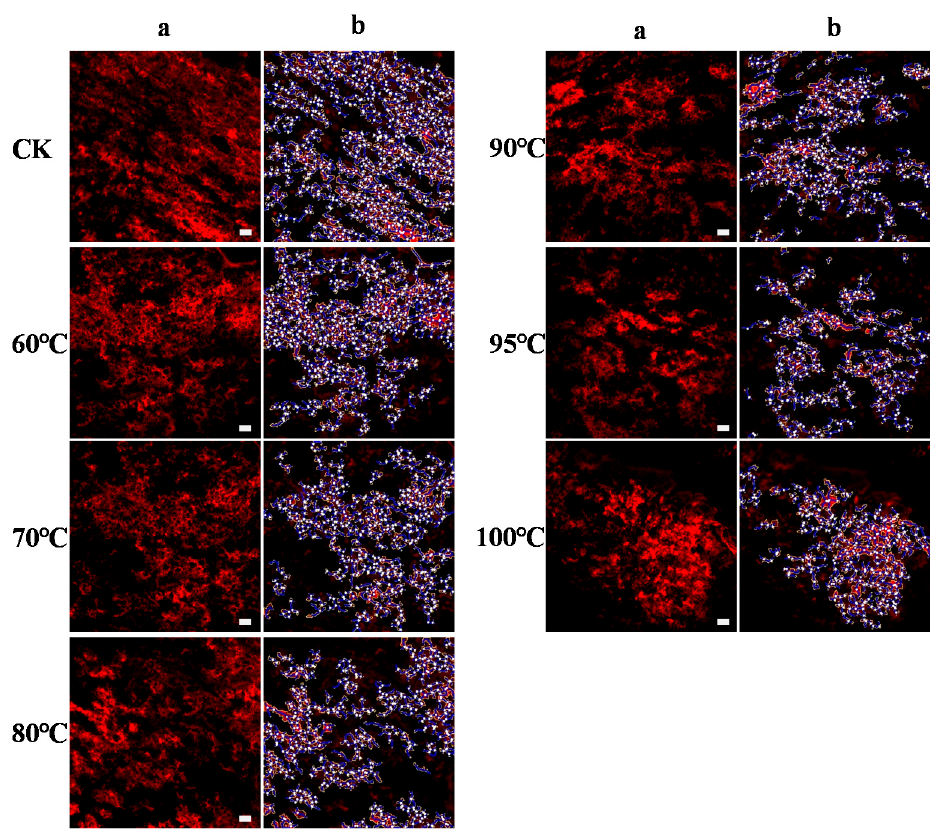
Figure 4. Morphological properties of protein network during heating of wheat flour obtained by CLSM. ( a ) images of protein network captured by CLSM, ( b ) images processed by Angiotool to visualize the protein network. Size bar = 20 μ m. Table 1. Image analysis of CLSM of wheat protein in dough of different heating treatments.